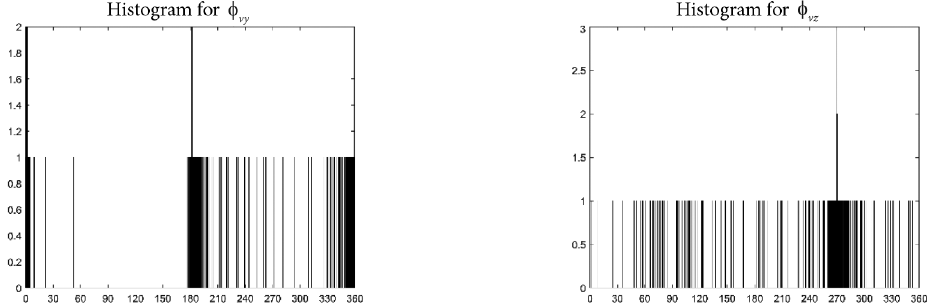
Figure 12. Histograms for angle coordinates of two orthogonal VPs for Camera-II